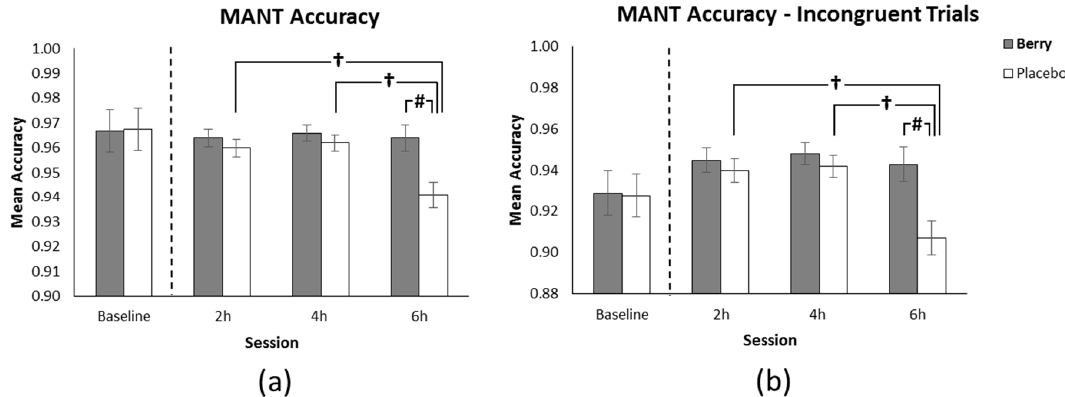
Figure 3. ( a ) Mean correct responses (±SE of the mean) as a function of intervention and session, showing a significant reduction in accuracy for placebo at 6 h in comparison to 2 and 4 h and significantly better performance in the berry condition in comparison to placebo at 6 h. ( b ) Mean correct incongruent trial responses (±SE of the mean) as a function of intervention and session showing a significant reduction in accuracy for placebo at 6 h in comparison to 2 and 4 h and significantly better performance in the berry condition in comparison to placebo at 6 h. Baseline performance, included as a covariate in the analysis, is shown on both graphs separated by the dotted line. # p < 0.01, † p <